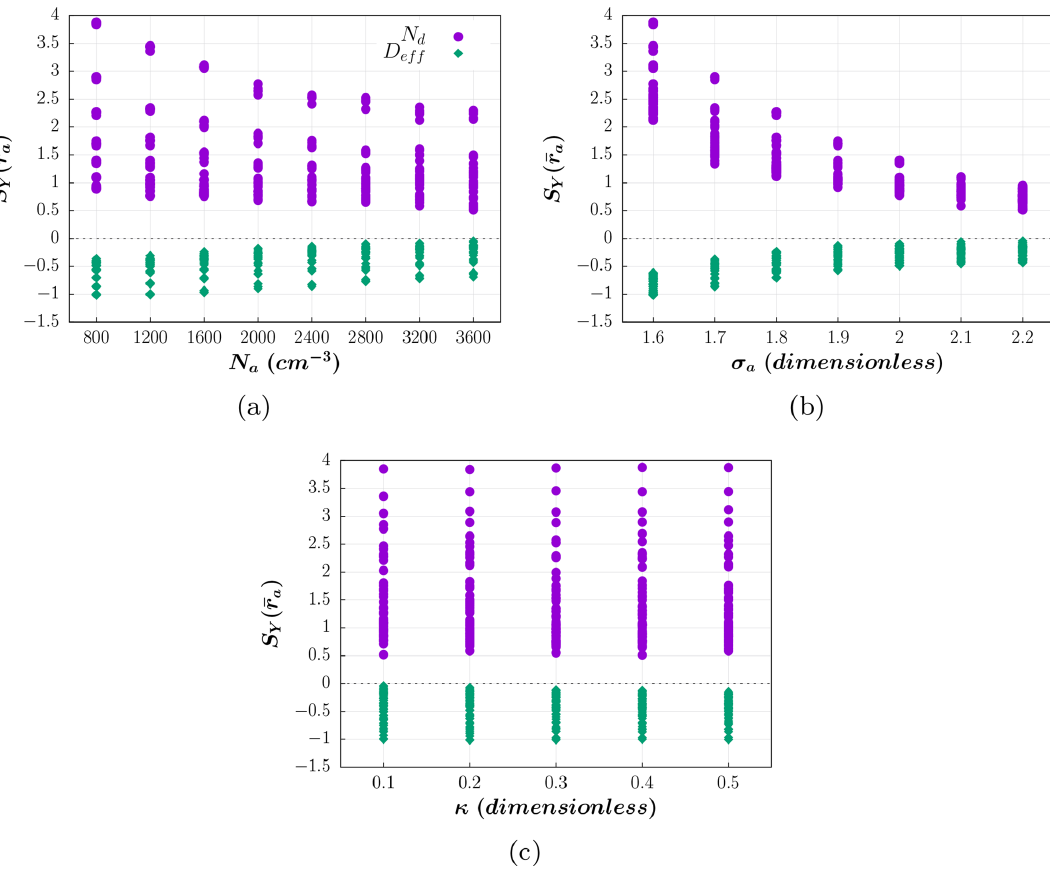
Figure 5. Sensitivities of the droplet number concentration and effective diameter to the median radius of the PSD, S Y (r a ) , as a function of (a) the aerosol number concentration (cm − 3 ), (b) the geometric standard deviation of the PSD (–) and (c) the aerosol hygroscopicity (–).